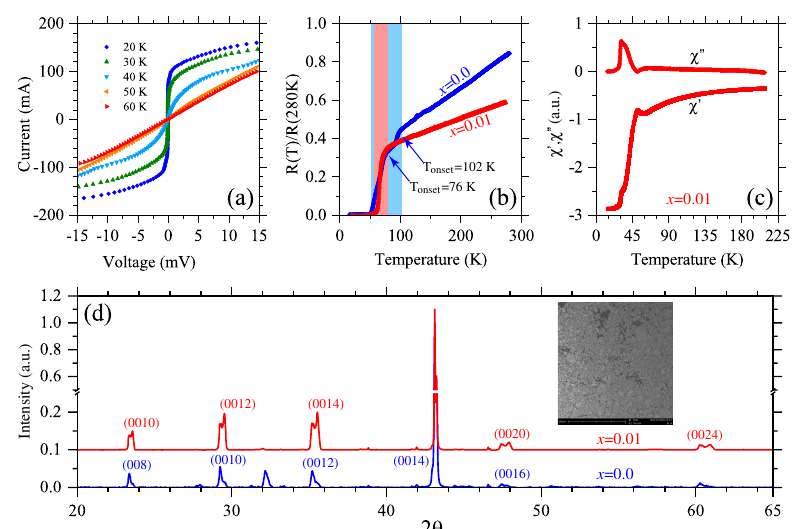
Figure 2. ( a ) Current-voltage curves for S 2 /MgO measured at different temperatures. ( b ) Resistance versus temperature measurements for the samples (S 2 ) 1 − x (S 1 ) x . Two superconducting critical temperatures can be observed around 76 K and 102 K for x = 0.0, in contrast with a single critical temperature around 76 K for x = 0.01. The regions of interest are shadowed in figure: 50–102 K for blue region; 50–76 K for red region. ( c ) Real ( χ (cid:48) ) and imaginary ( χ (cid:48)(cid:48) ) parts of the magnetic susceptibility as function of the temperature for x = 0.01. ( d ) Comparative XRD spectra for x = 0.0 and x = 0.01. A SEM micrograph of the sample with x = 0.01 is presented in the inset of ( d ).